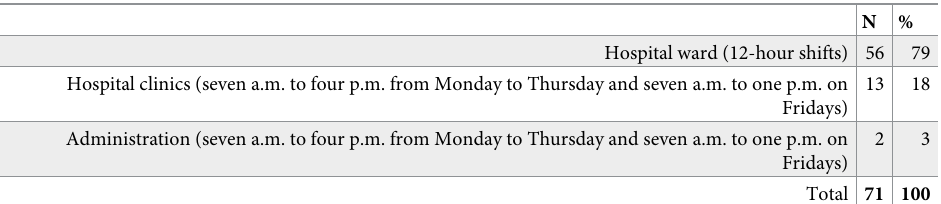
Table 2. Paid worksite and schedule.